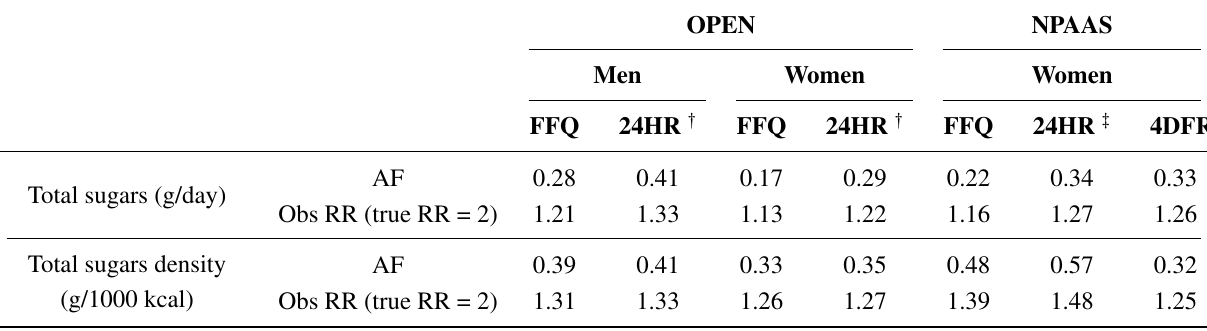
Table 1. Attenuation factors (AF) for self-reported total sugars in the OPEN and NPAAS studies from a measurement error model with urinary sugars biomarker as a reference instrument and observed relative risk (RR) for true RR = 2 [52,61]. OPEN NPAAS